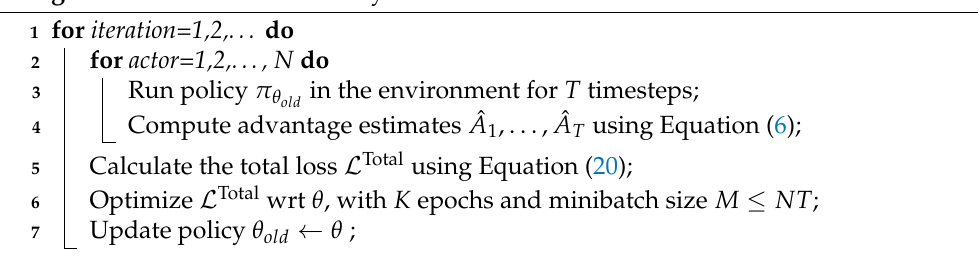
Algorithm 1: PPO with auxiliary